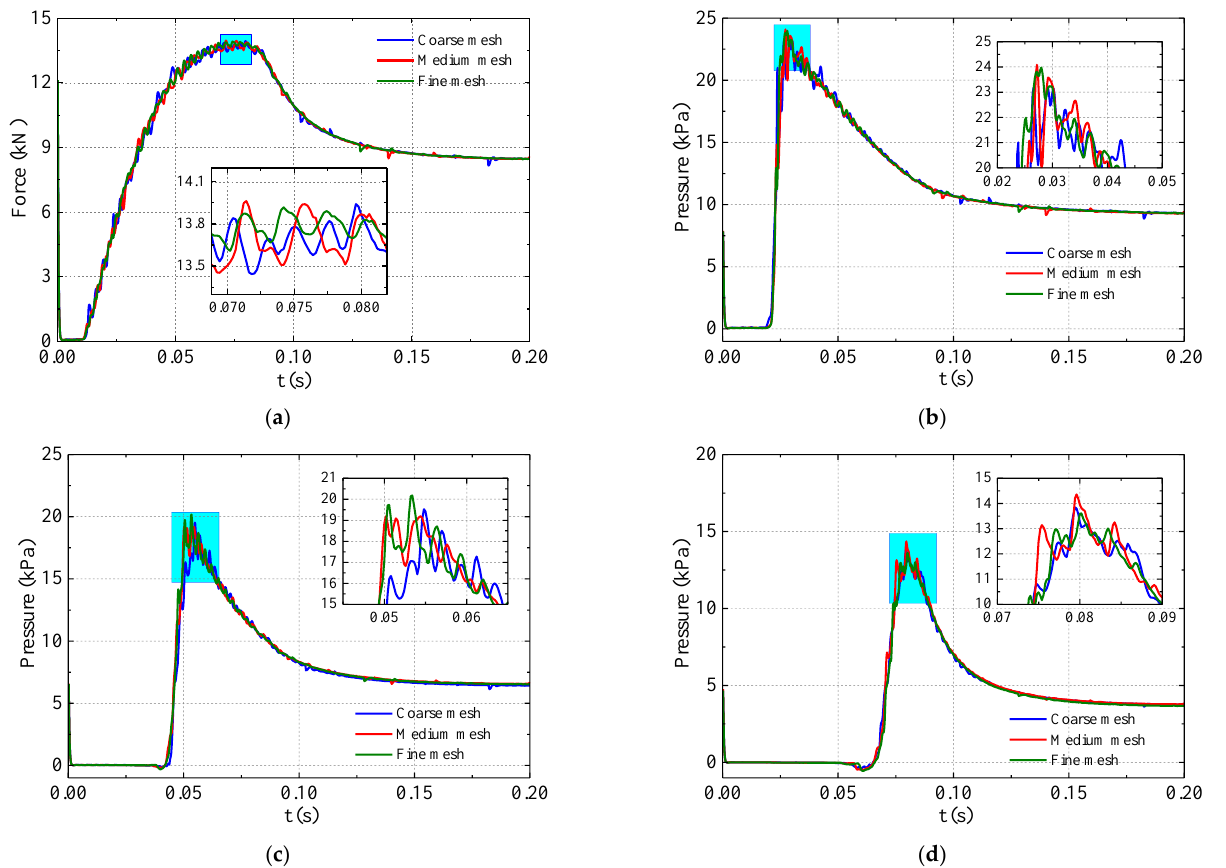
Figure 13. Comparison of time series of slamming results by different CFD grid schemes: ( a ) vertical total force; ( b ) pressure at P1; ( c ) pressure at P3; ( d ) pressure at P5.